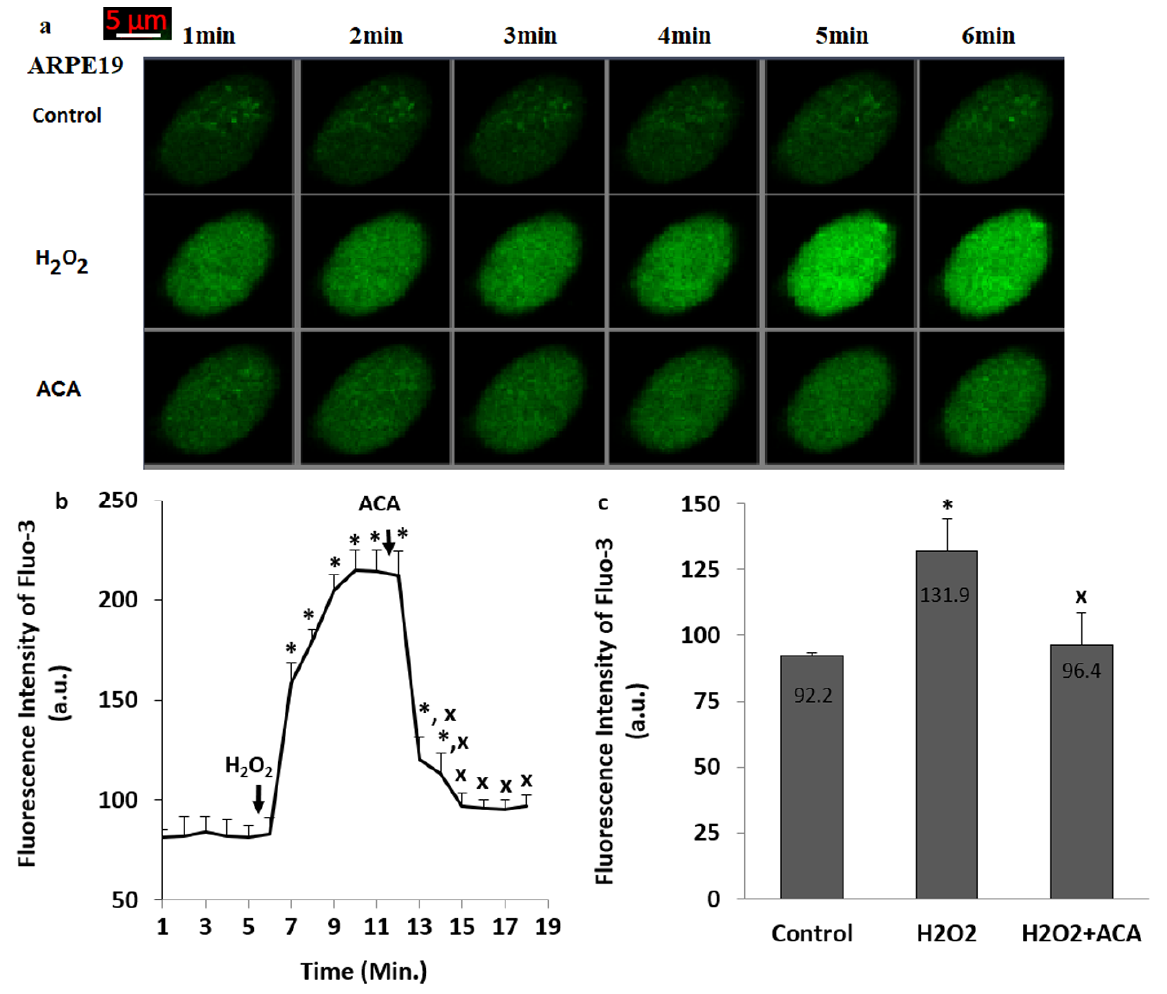
Figure 2. The H 2 O 2 -mediated upregulation of Ca 2+ fluorescence intensity through the stimulation of TRPM2 in the ARPE19 . (n = 25–30). After incubating the ARPE19 cells with Fluo-3AM (1 µ M for 60 min), the TRPM2 stimulator (H 2 O 2 and 1 mM) and blocker (ACA and 25 µ M for 6 min) applied to the cells within three groups (control, H 2 O 2 and H 2 O 2 + ACA). The cells were analyzed. The fluorescence intensity of Fluo-3AM in the ARPE19 was imaged at 515 nm in the LSM 800 laser scan microscope with 40 × 1.3 oil objective and the results were indicated as arbitrary unit (a.u.). ( a ) Imagines of the Fluo-3AM. ( b , c ) The mean fluorescence intensity of Ca 2+ in the column and line figures were expressed as Mean ± SD in the ARPE19 after the treatments of H 2 O 2 and ACA. (* p ≤ 0.05 vs. control. x p ≤ 0.05 vs. H 2 O 2 group).